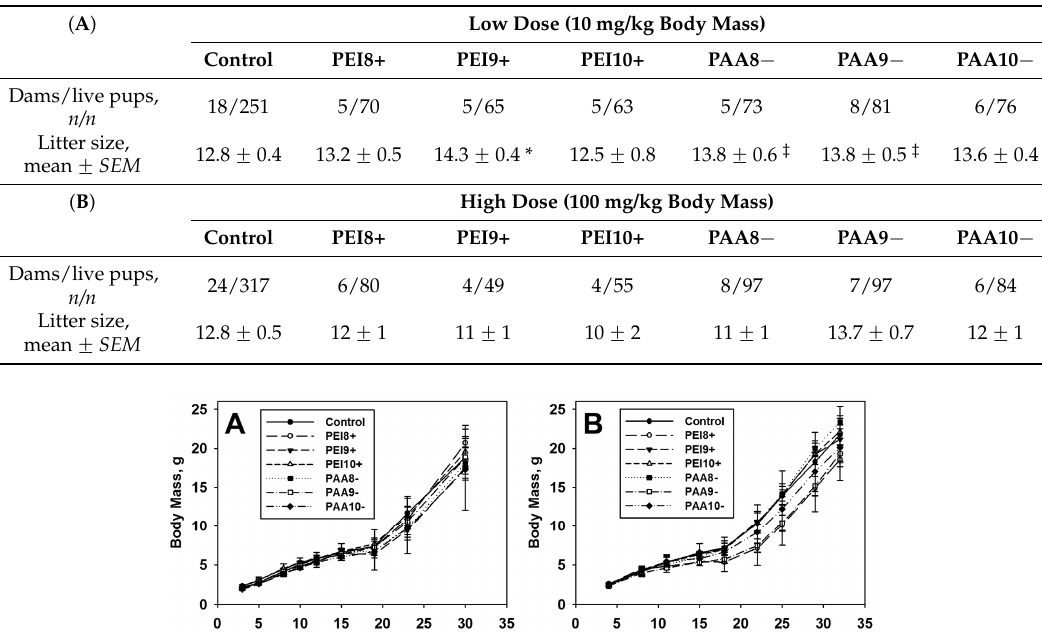
Table 4. Litter parameters for offspring exposed to 10 mg/kg ( A ) or 100 mg/kg ( B ) of iron oxide NPs on GD 8, 9, or 10 in utero . Litter size represents results from cesarean evaluations and pups birthed naturally. * Significant differences between treatment and control ( p < 0.05). Controls from both replicates were combined for litter size analyses as they underwent identical treatments. ‡ Trends between treatment and control at ( p < 0.1).